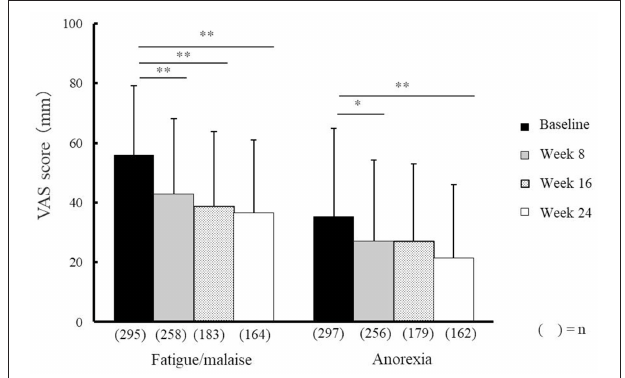
FIGURE 2 | Effectiveness of Ninjin’yoeito against fatigue/malaise and anorexia. Changes in VAS scores for fatigue/malaise and anorexia after Ninjin’yoeito (NYT) administration, Data are presented as the mean ± standard deviation, * p < 0.05 and ** p < 0.01 compared with the baseline as determined using the Bonferroni method. VAS, visual analog scale; ( n ), number of